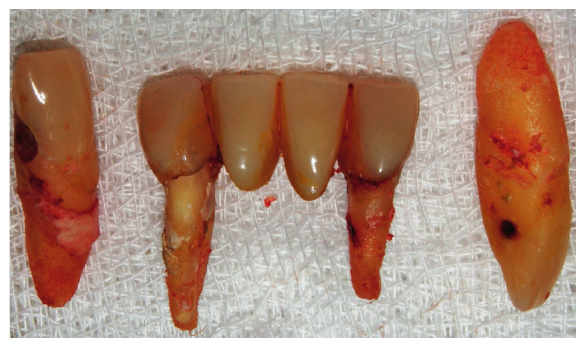
Figure 1: Atraumatic dental